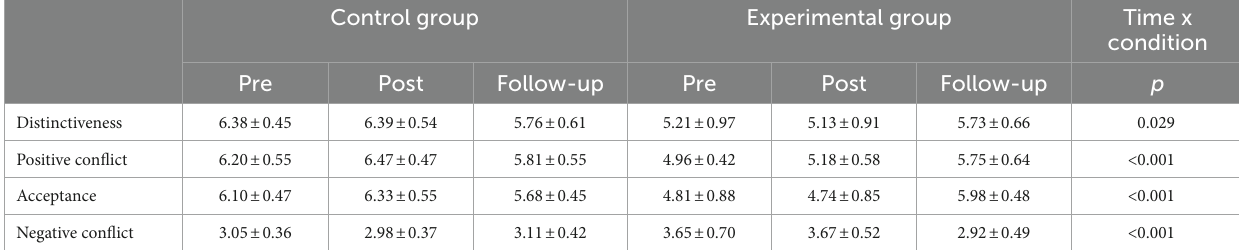
TABLE 3 Results of mixed repeated-measures ANOVA in variables related to team